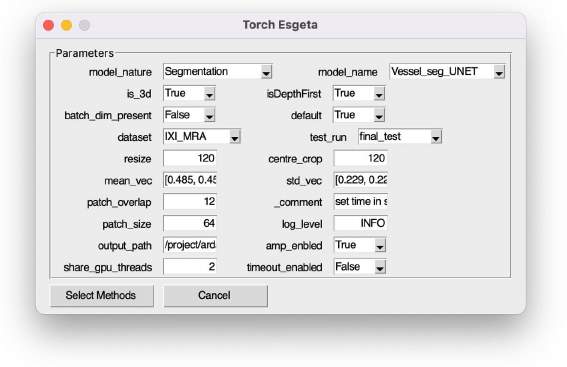
Figure 2. GUI: General parameter selection. Select the desired common parameters for running the pipeline, including the selection of the model.